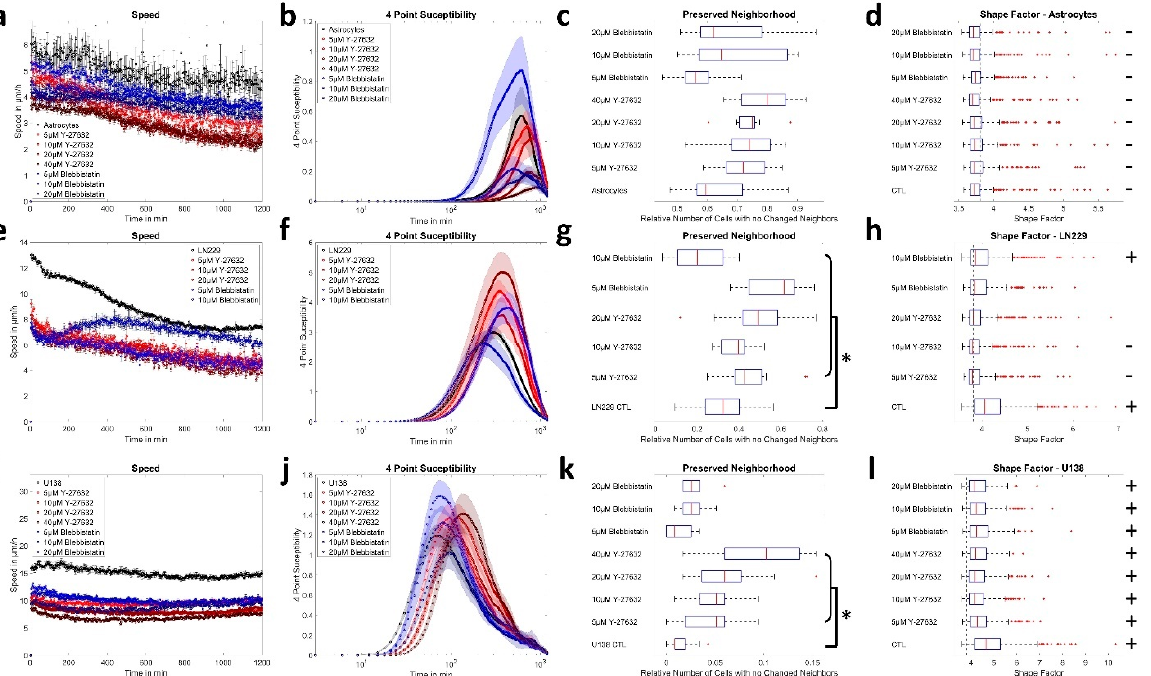
Figure 5. Effect of myosin II and ROCK inhibition on collective migration. ( a , e , i ) Mean speed per field of view for astrocytes, LN229 and U138 cells treated with ROCK inhibitor Y-27632 or myosin II inhibitor blebbistatin. For astrocytes, 15 fields of view were measured for all conditions. For LN229 and U138 cells 81 or 33 fields of view were assessed in control conditions and 15 otherwise. ( b , f , j ) 4-point susceptibility over the whole measurement time for astrocytes, LN229 and U138. Peak positions of the 4-point susceptibility represent the average life time of collectively moving packs of cells. Sample sizes are the same as in ( a , e , i ), respectively. ( c , g , k ) cell layer reorganization in terms of changed neighborhood. Sample sizes are the same as in ( a , e , i ), respectively. Here p < 0.001 for all instances of U138 and LN229 cells except for LN229 treated with 10 µM Y-27632 ( p < 0.05). ( d , h , l ) illustrate the difference in shape factor for astrocytes, LN229 and U138 cells. The dotted line shows the critical value of 3.81 predicted by the vertex model. Below cells are considered to be jammed. “+” and “ − ” depict if shape factors are significantly larger or smaller than the critical value, as assessed by sign test. Here p < 0.0001 holds for all instances of astrocytes, U138 cells and LN229 cells in control conditions or when treated with 10 µM blebbistatin. p < 0.01 for LN229 cells treated with 5 µM Y-27632 and p < 0.05 for LN229 treated with 10 µM Y-